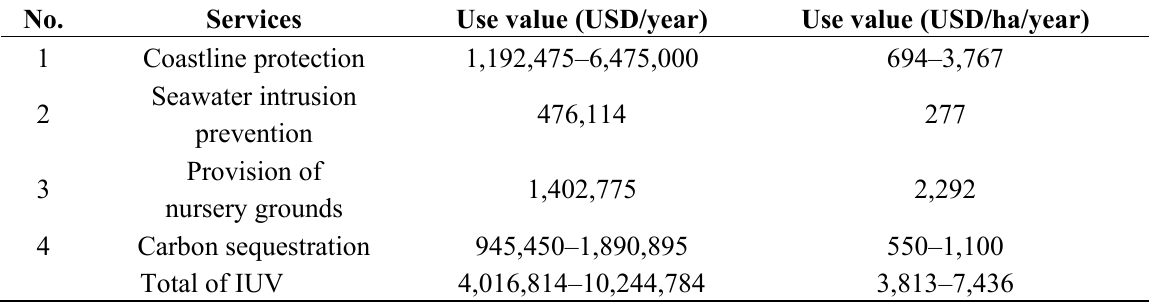
Table 2. The Inderect Use Value (IUV) of mangrove in the Takalar district, South Sulawesi,